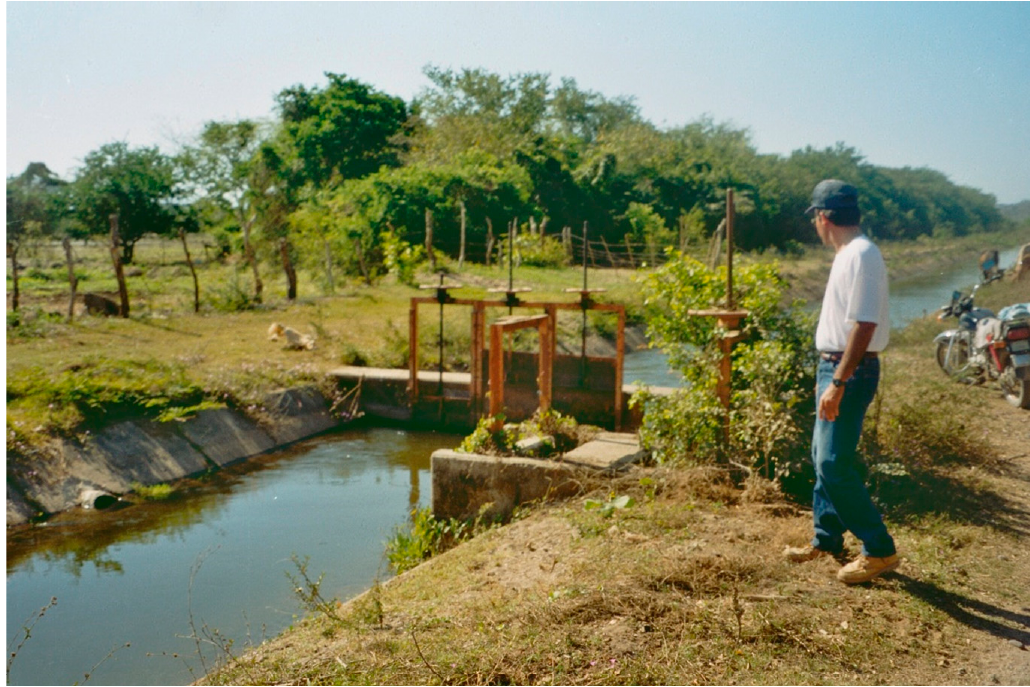
Figure 4. The canalero near a cross-regulator and intake structure.